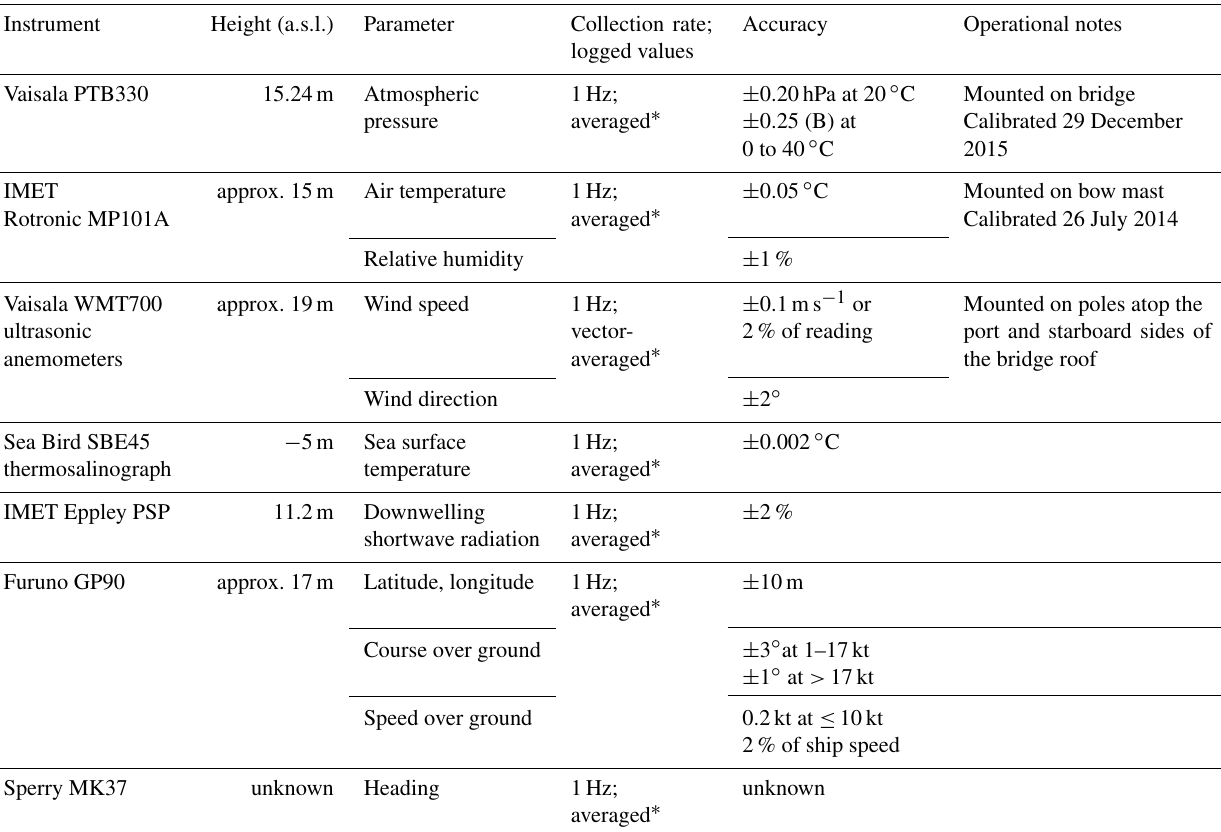
Table 2. Surface meteorology instruments deployed aboard NOAA Ship Ronald H. Brown during the ENRR field campaign. The Improved Meteorology (IMET, Hosom et al., 1995) instruments are modified versions of the original manufacturer instruments, as described in the Woods Hole Oceanographic Institution (WHOI, 2010a,